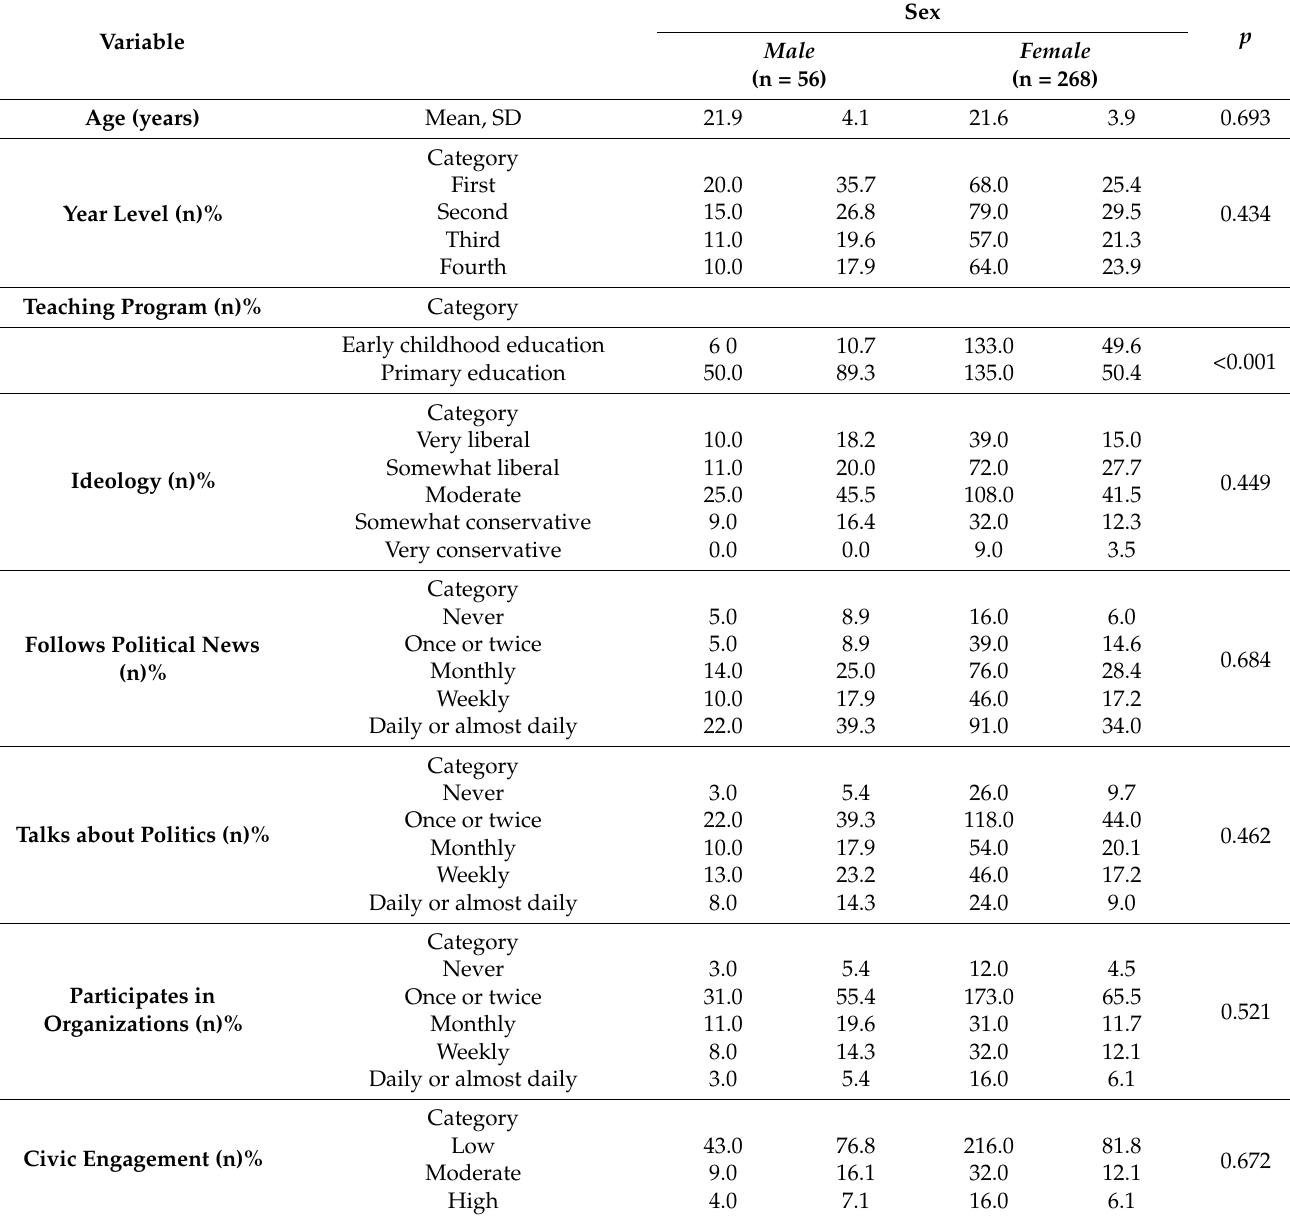
Table 3. Quantitative descriptive